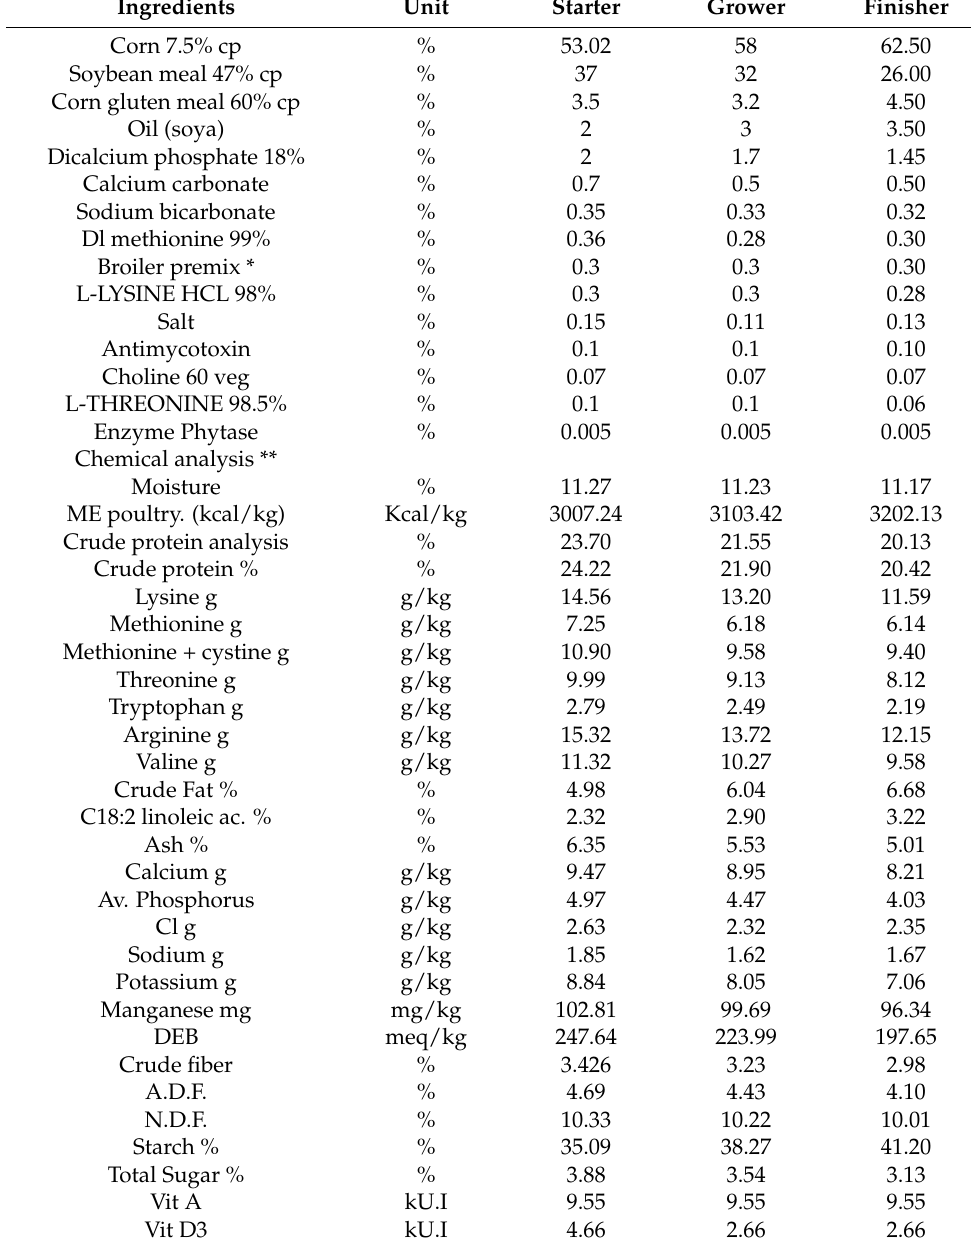
Table 1. The proximate chemical composition of the basal diet as fed basis